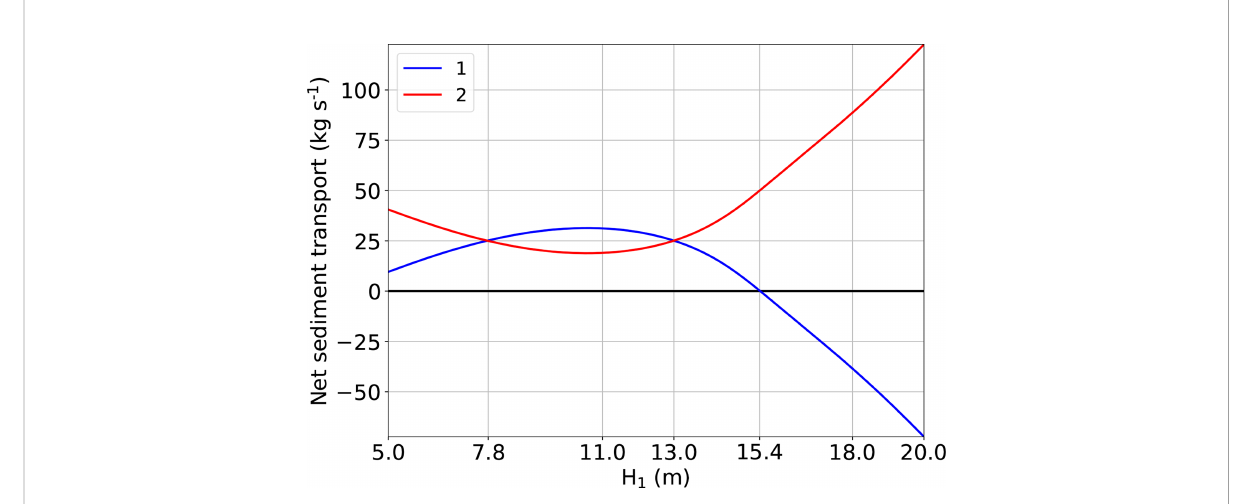
FIGURE 9 Sensitivity of net sediment transport in Channels 1 and 2 to the mean water depth of Channel